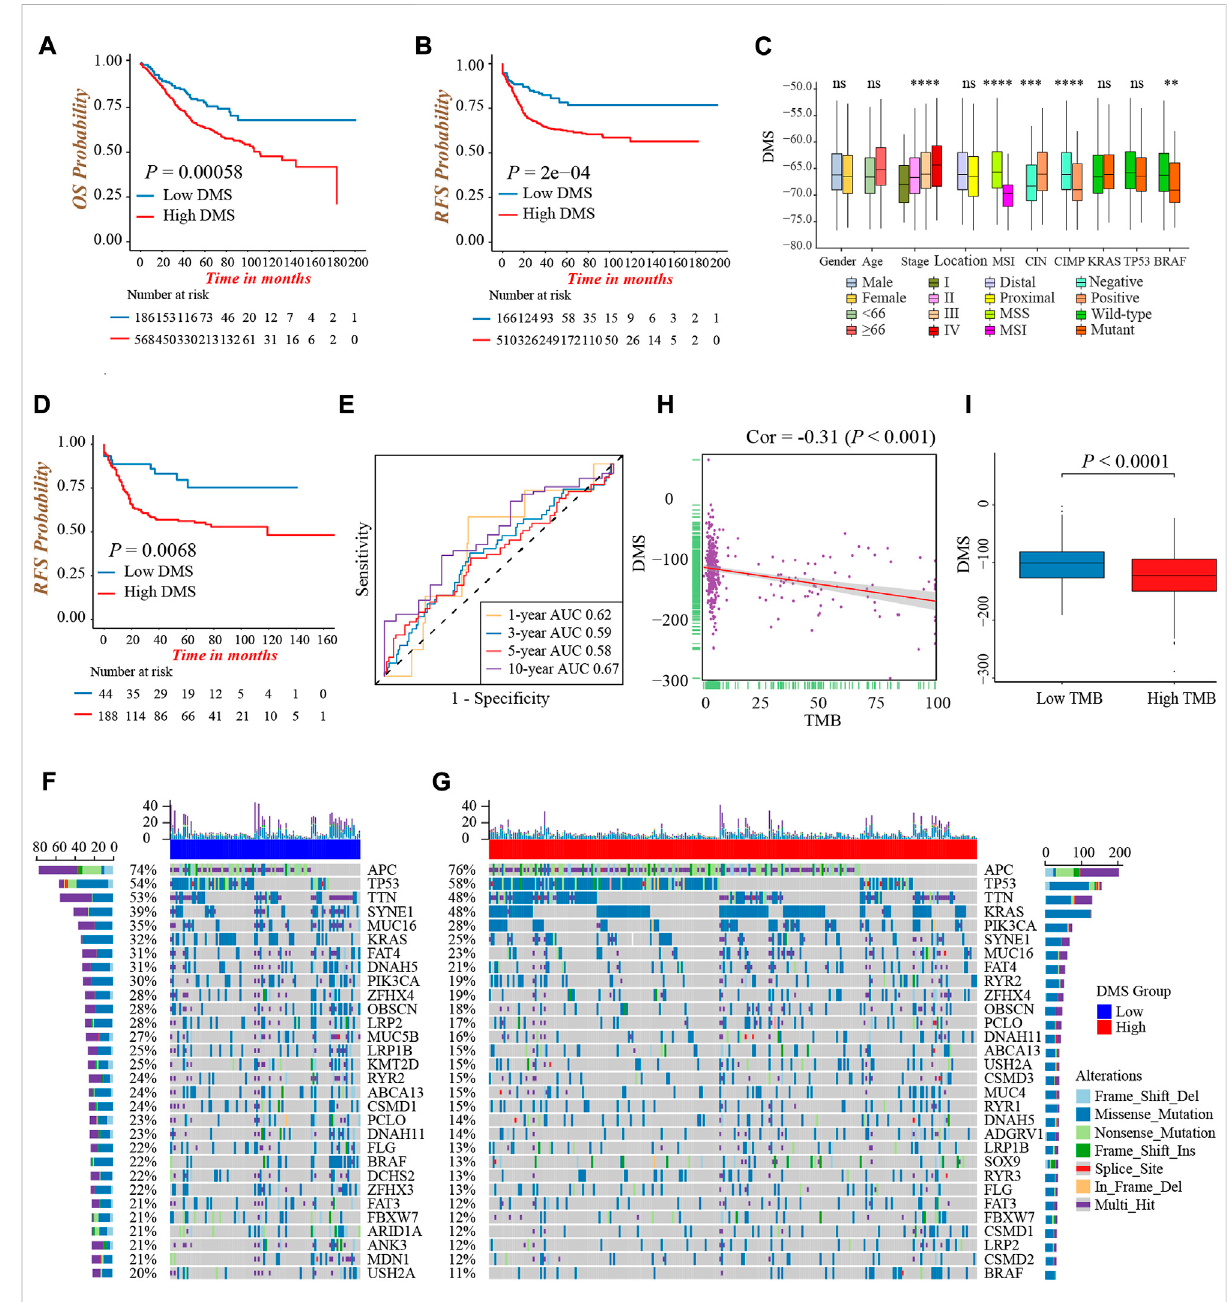
Characterization of DNA methylation score in different clinical and molecular traits. (A) Overall survival analysis for low and high DMS groups in themeta-cohort (Log-rank test, p = 0.00058). (B) Recurrence-free survival analysis for low and high DMS groups in the meta-cohort (Log-rank test, p = 0.0002). (C) Difference in DMS among distinct clinical subgroups in the GSE39582 cohort. MSI, microsatellite instability; CIMP, CpG island methylatorphenotype;CIN,chromosomeinstability.(Wilcoxontest;ns:nosigni fi cance;* p < 0.05;** p < 0.01;*** p < 0.001;**** p < 0.0001). (D) Recurrence-free survival analysis for low and high DMS groups among patients received chemotherapy in the GSE39582 cohort (Log-rank test, p = 0.0068). (E) ROC curves to re fl ect the ability of DMS to predict the 1-, 3-, 5-, and 10-year survival probability for patients received chemotherapy in the GSE39582 cohort. (F,G) The waterfall plot presented the distribution differences of tumor somatic mutation between DMS-low (F) and -high groups (G) . (H) Thescatter plotdepictedthenegativecorrelationbetweenDMSandTMBintheTCGA-COADcohort(Spearmancorrelationanalysis; p < 0.001). (I) Comparison of DMS between the TMB high and low groups (Wilcoxon test; p <